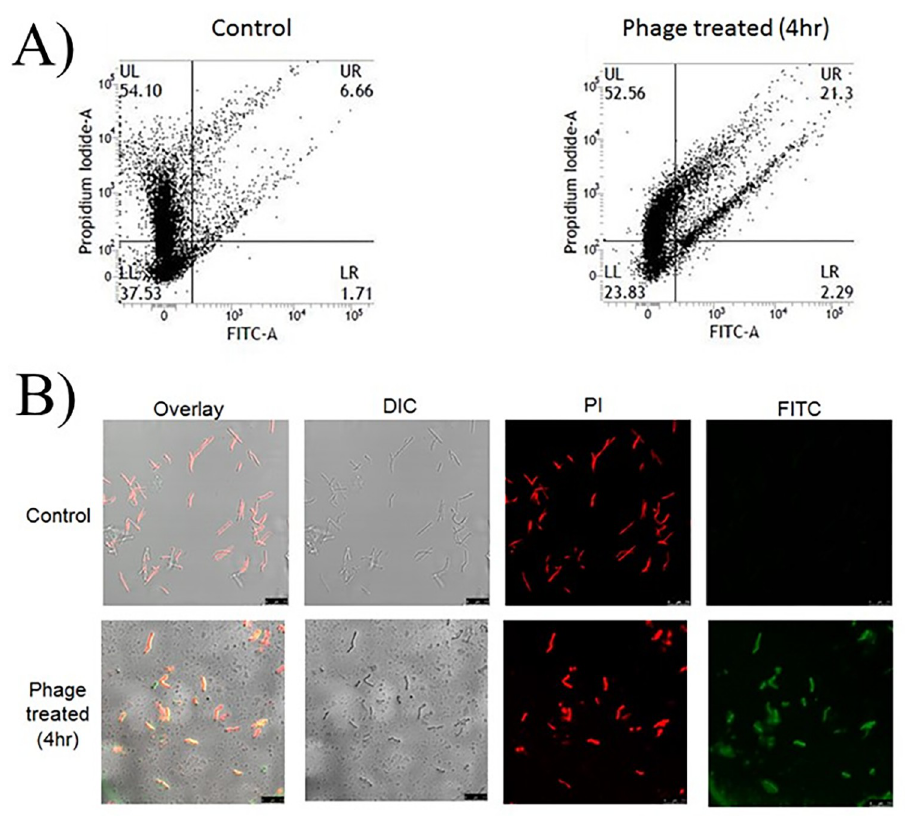
Fig 6. DNA fragmentation detected by the TUNEL assay. (A) FACS based assay and (B) depicts confocal microscopic analysis of phage infected cells. In (A) the quadrants are indicated as UL (Upper Left), UR (Upper Right), LL (Lower Left) and LR (Lower Right). The numbers denote the percentage of cells in the quadrants. The threshold was set using untreated and unstained Msm cells. FITC-fluorescein isothiocyanate, SSC-side scatter. Microscopic analysis of phage-infected and control cells stained with the dyes propidium iodide (PI) and FITC. Scale bars 7.5 μ m.